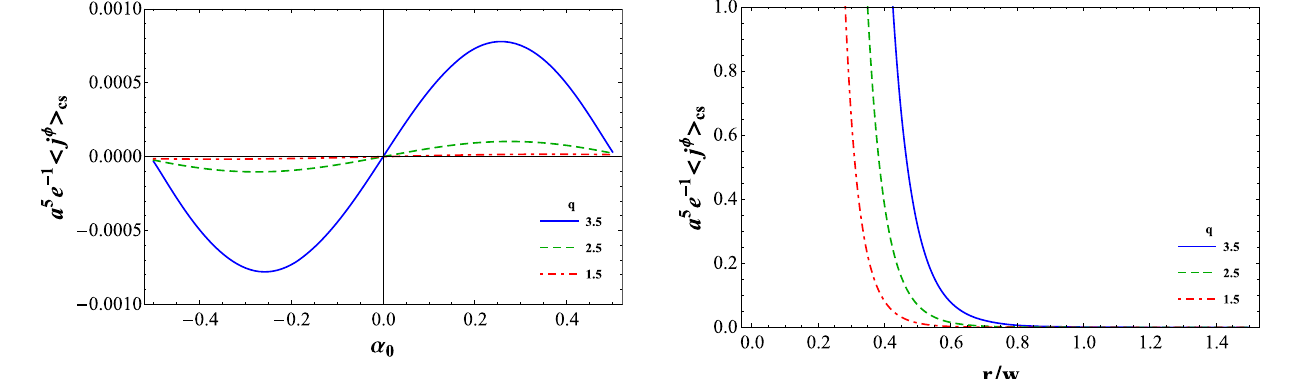
Fig. 1 The VEV of the induced azimuthal current without compacti- fication in (3.15) is plotted, in units of a 5 e − 1 , as a function of α 0 for r /w = 1, ma = 5, q = 1 . 5 , 2 . 5 and 3 . 5